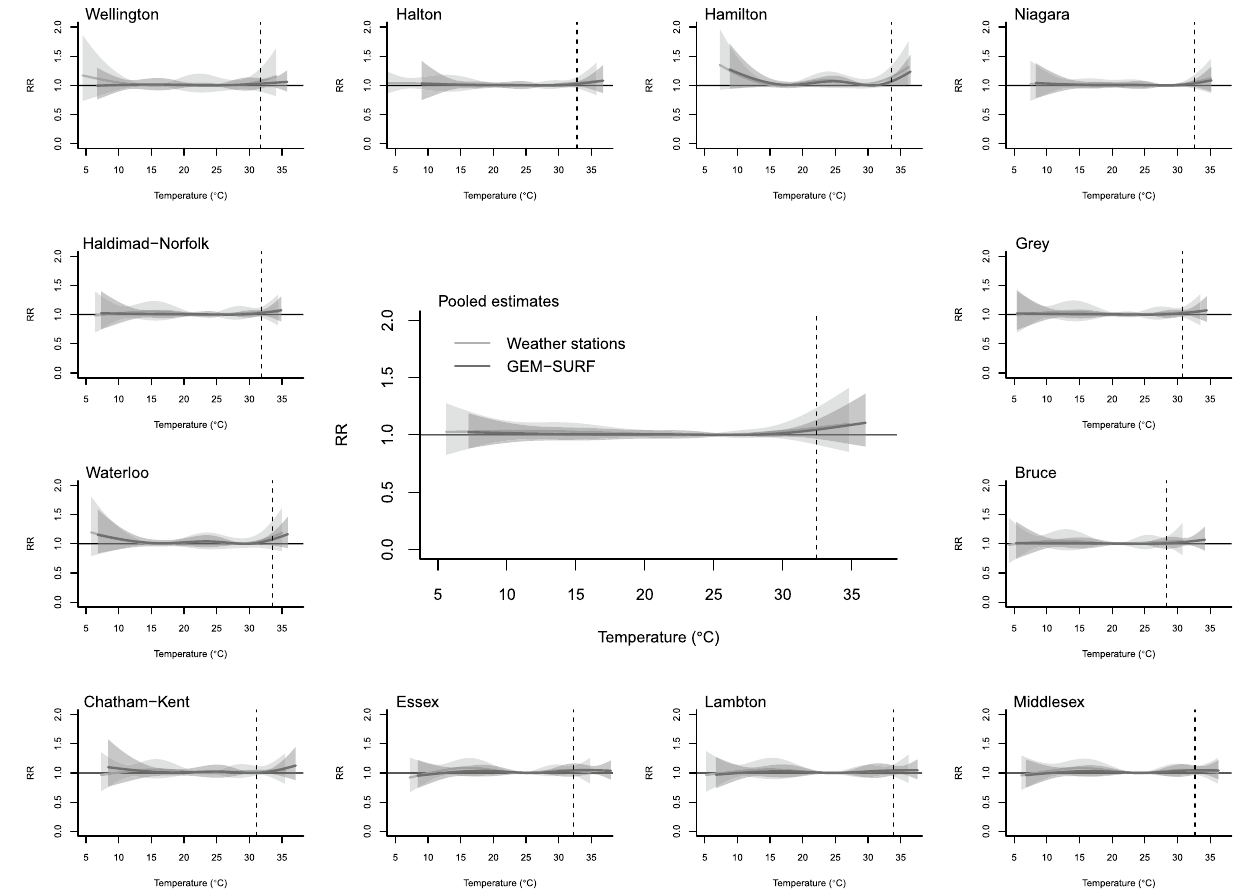
Figure 3. Cumulative association between mortality and maximum daily temperature by region and pooled across Southwestern Ontario between May–September 2005–2012, centered at minimum mortality temperature. Curves are presented using both GEM-SURF and weather station data. The dashed line represents the 99th percentile of weather stations temperature distribution.